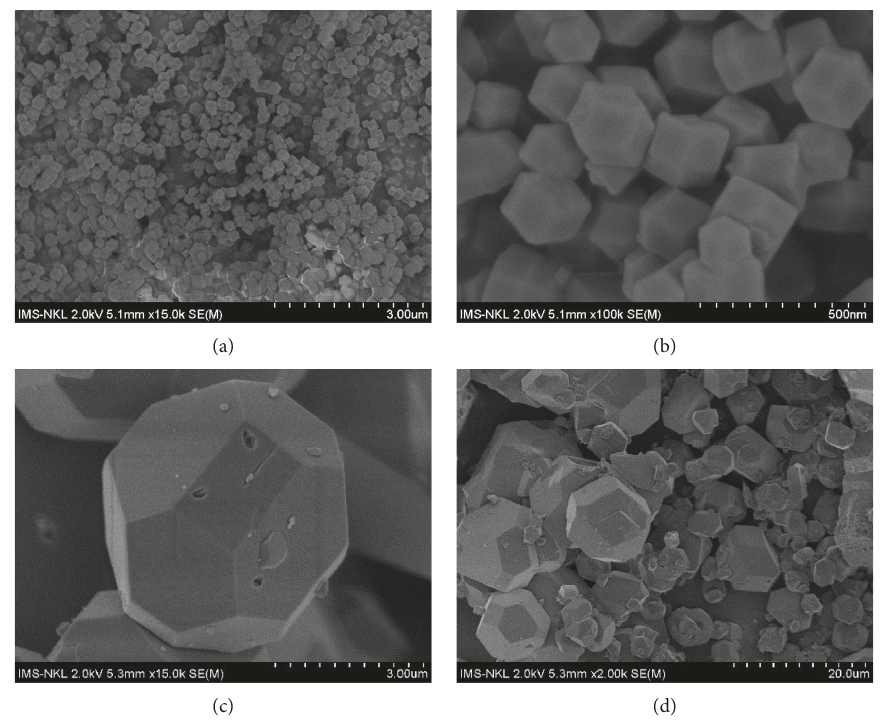
Figure 2: SEM images of Z-A(MeOH) (a, b) and Z-B(DMF) (c,